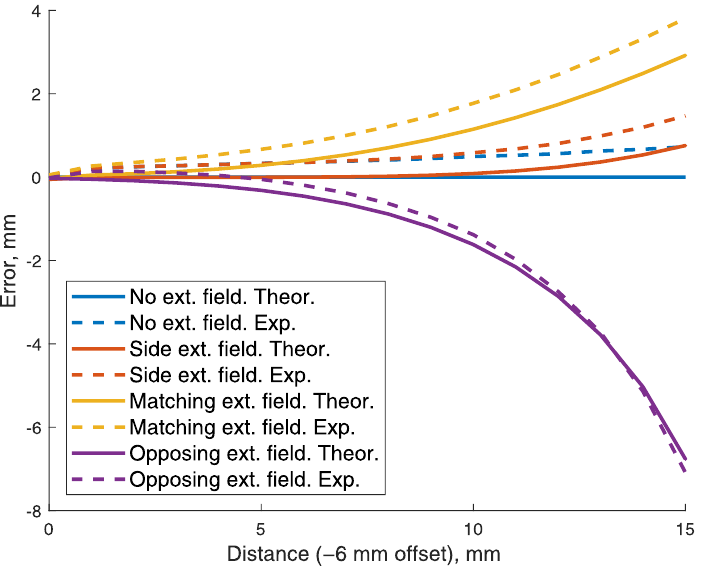
Figure 7. Errors induced by artificial, maximal B field of the Earth (65 µ T), acting in various directions. Both on theoretical and experimental